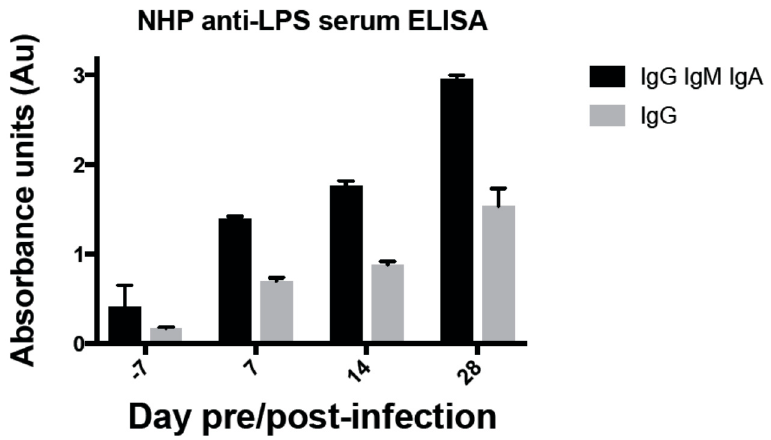
Figure A1. Non-human primate pre/post challenge anti-LPS responses.